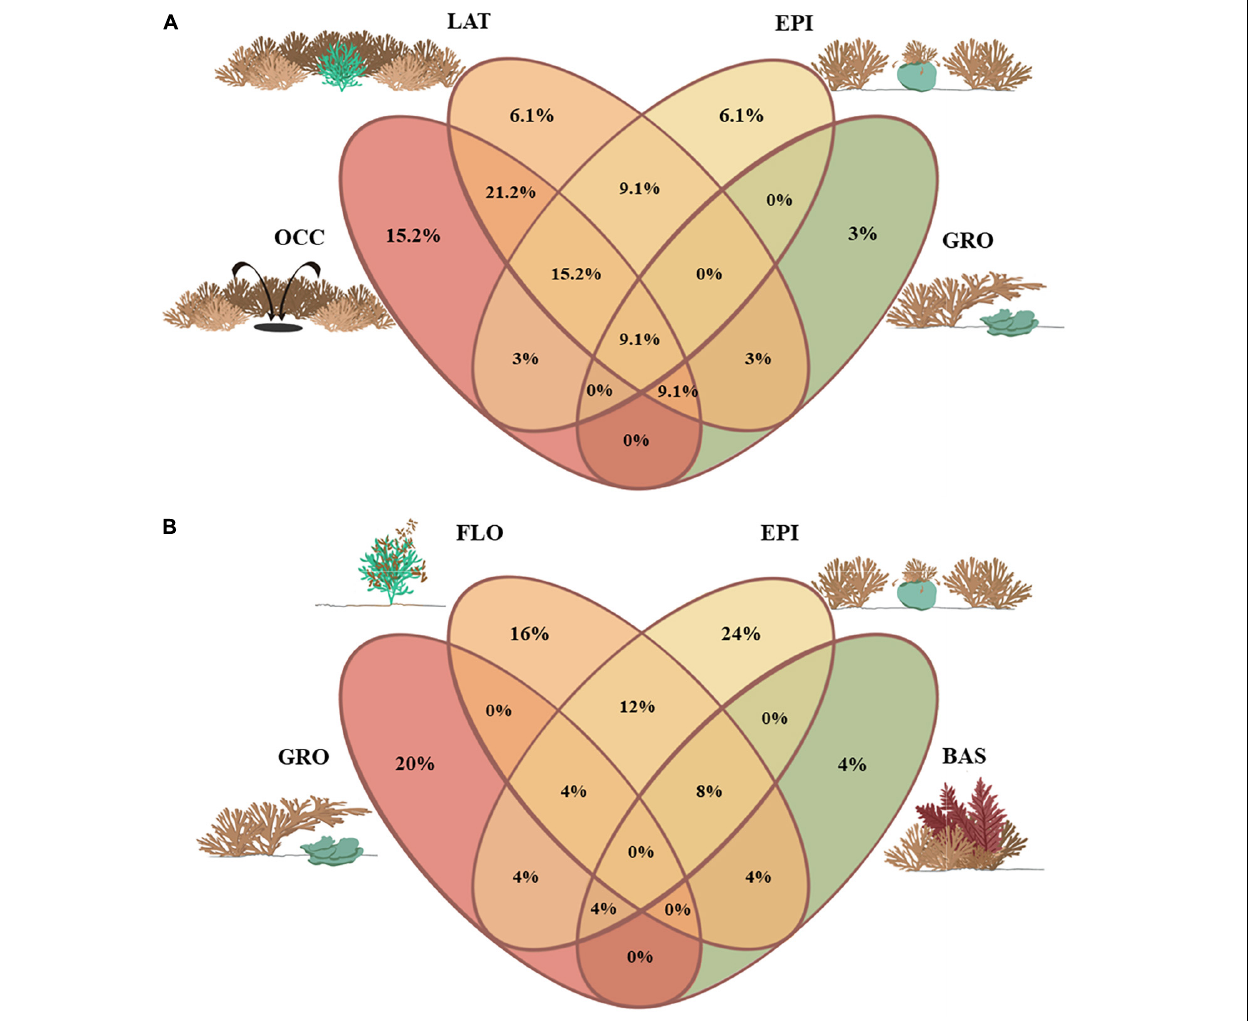
FIGURE 5 | Venn diagrams showing the percentage of resident macroalgal species contained in each possible combination of the colonization strategies described for R. okamurae (RO) and the resident macroalgal commnunity: (A) spatial exclusion interactions and (B) overgrowth interactions. [LAT, RO laterally compress the resident species; EPI, RO epiphytes the resident species; GRO, RO grows and develops on the resident species without being attached on it; OCC, RO is established on the free substrata left by the resident species when the latter dies; FLO, RO remains free-floating on the resident species thallus without being attached on it; BAS, RO is epiphyted by the resident species (i.e., RO was observed as basibiont)].